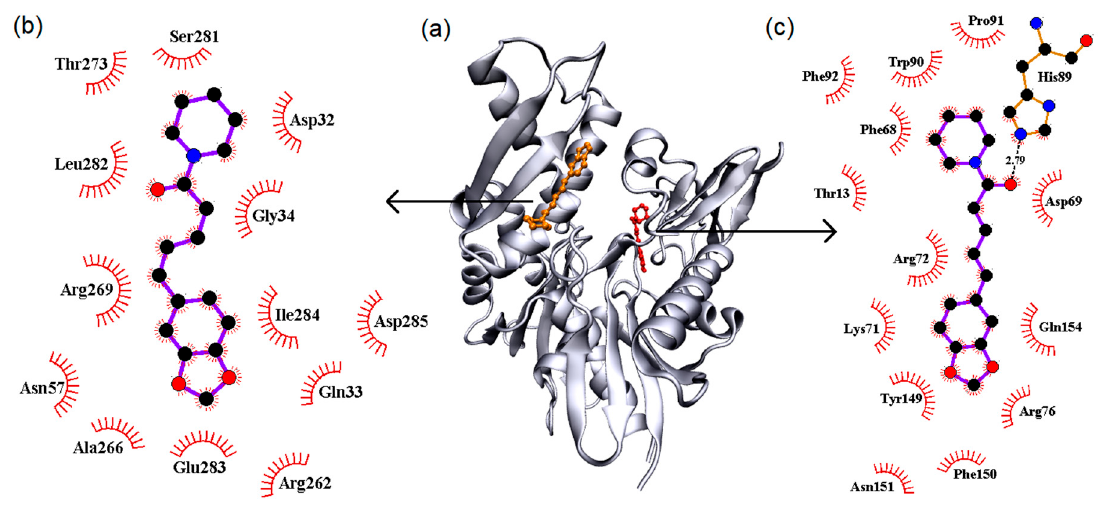
Figure 8. The central picture represents the molecular docking ( a ) in a general view. In red is piperine in binding site 1, in orange in site 2. Pose ( b ) binding environment of site 2, and ( c ) site 1 with a dotted line indicating the hydrogen